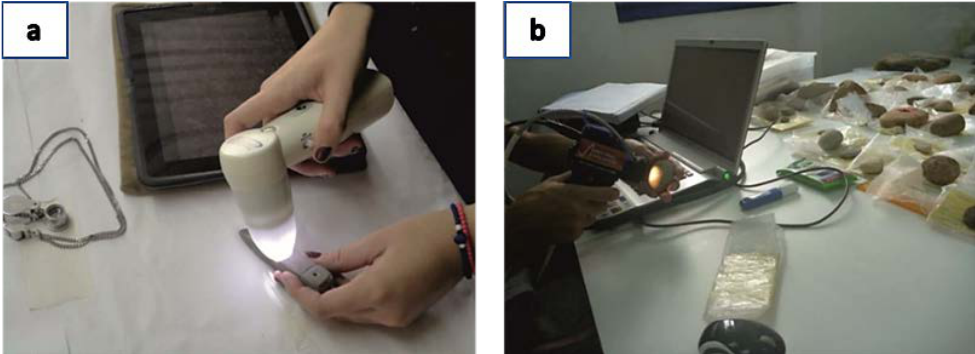
Figure 3. Non-destructive analytical techniques employed for the evaluation of the stone artefacts studied: ( a ) use of the WiFi ProScope mobile microscope paired with iPad; ( b ) use of Near Infrared (NIR) portable spectrometer SM-3500 specTERRA.